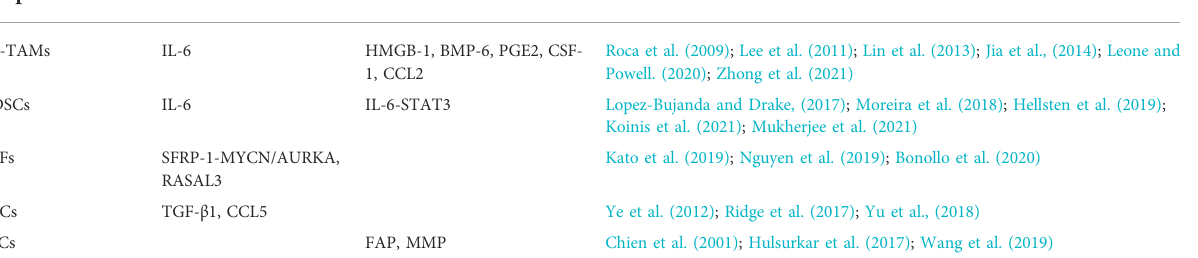
TABLE 1 Role of cellular components in the NEPC microenvironment. Cellular